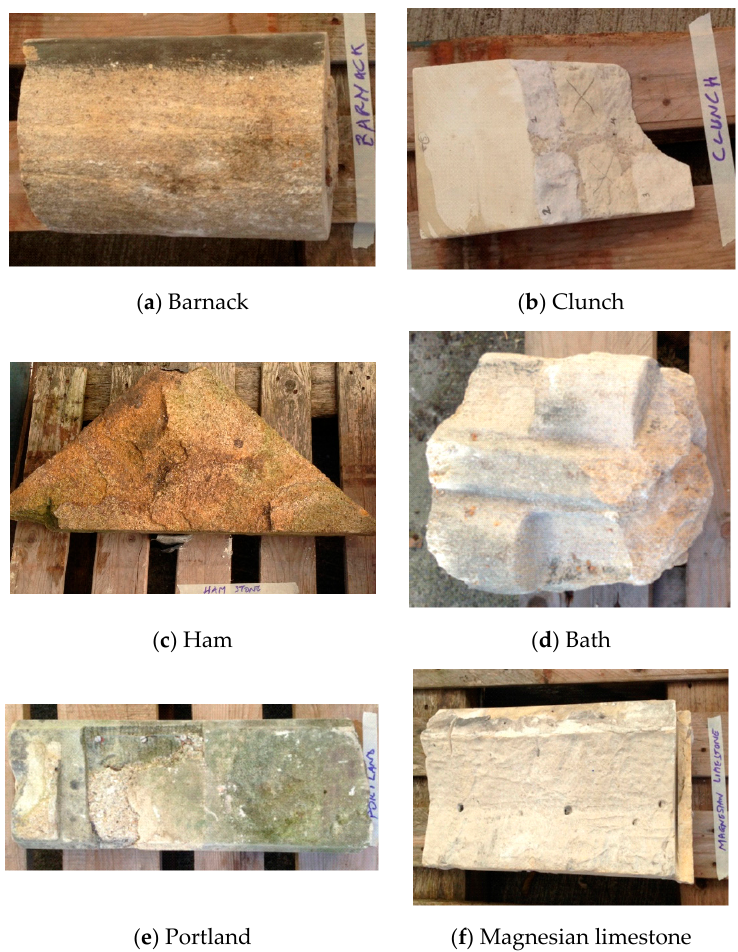
Figure 1. Images of the 6 different stone types used during the tests. In this image, the Barnack stone is represented only by the column used during the tests ( a ) whereas the Bath stone is represented only by one of the samples tested ( d ). The Magnesian limestone in the image ( f ) was split after the treatment. Sizes of stones can be estimated from the wooden slats of pallet in the background which are approximately 80 mm.